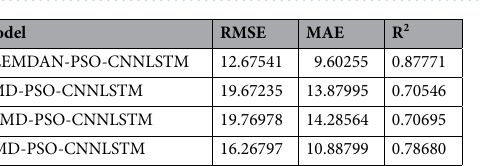
Figure 5. Binzhou’s PM2.5 decomposition results.